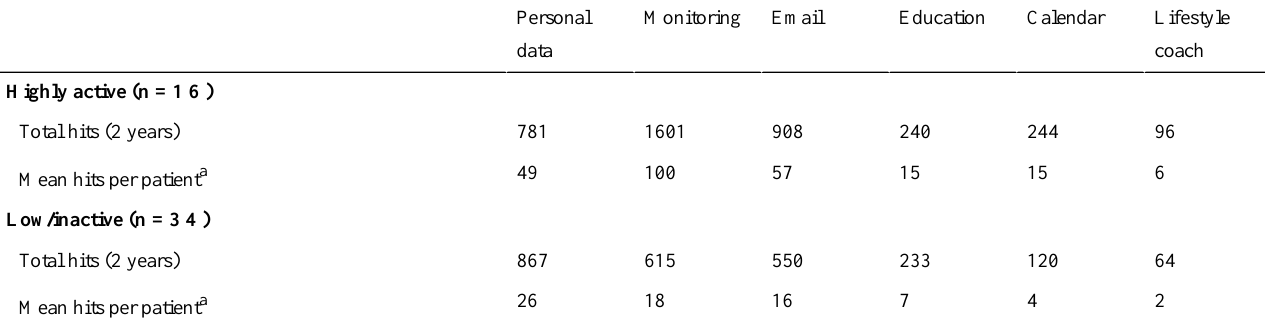
Table 6. User activity related to the use of system features: mean number of hits